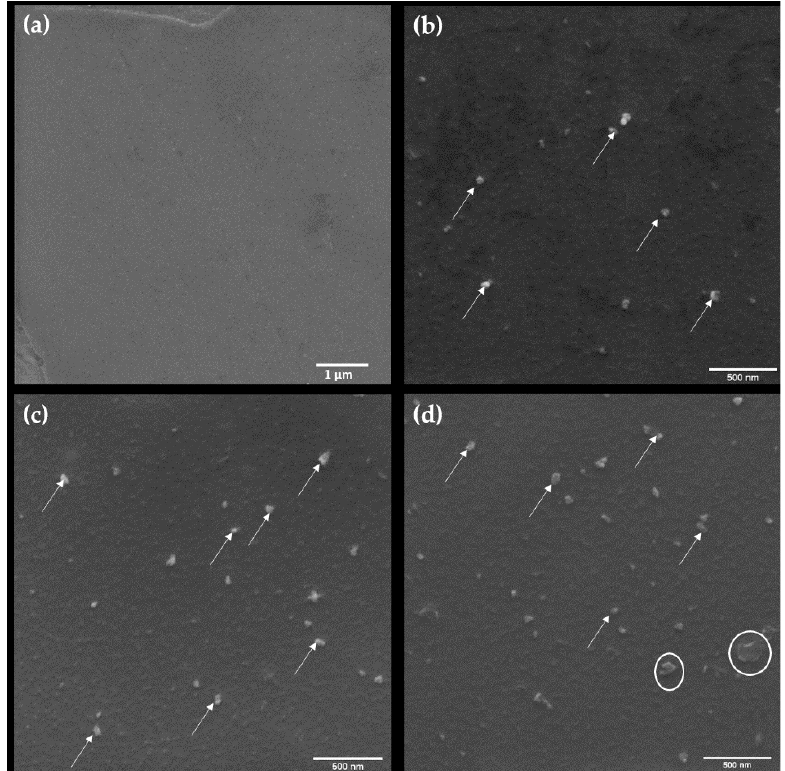
Figure 1. SEM images depicting the dispersion of nanoparticles in the ( a ) pure Mg, ( b ) Mg ‐ 0.5Si 3 N 4 , ( c ) Mg ‐ 1.0Si 3 N 4 , ( d ) Mg ‐ 1.5Si 3 N 4 .